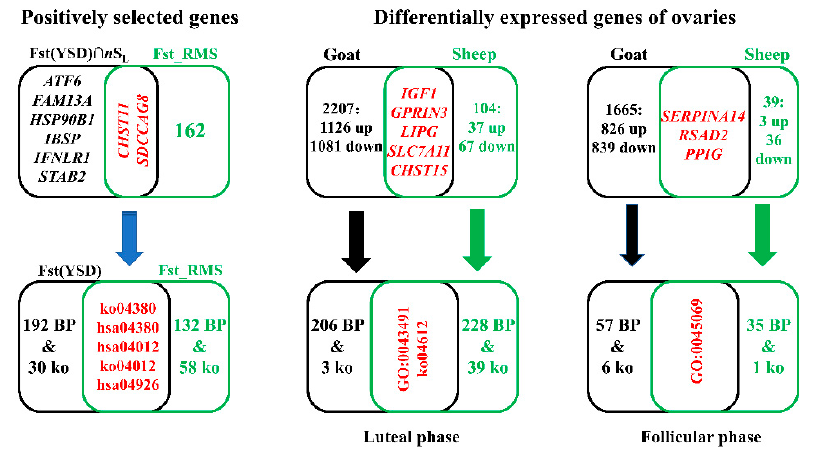
Figure 2. Venn diagrams of genetic convergence of prolificacy between goats and sheep. The top panels denote the convergence at the single gene level (positively selected genes and differentially expressed genes of ovaries), whereas the convergence at the gene set level is represented as Gene Ontology (GO) and Kyoto Encyclopedia of Genes and Genomes (KEGG) Ontology (ko) terms in the bottom panels; only biological processes (BP) were considered in GO analysis. Table 2. Pathways shared by positively selected genes of sheep and goats.